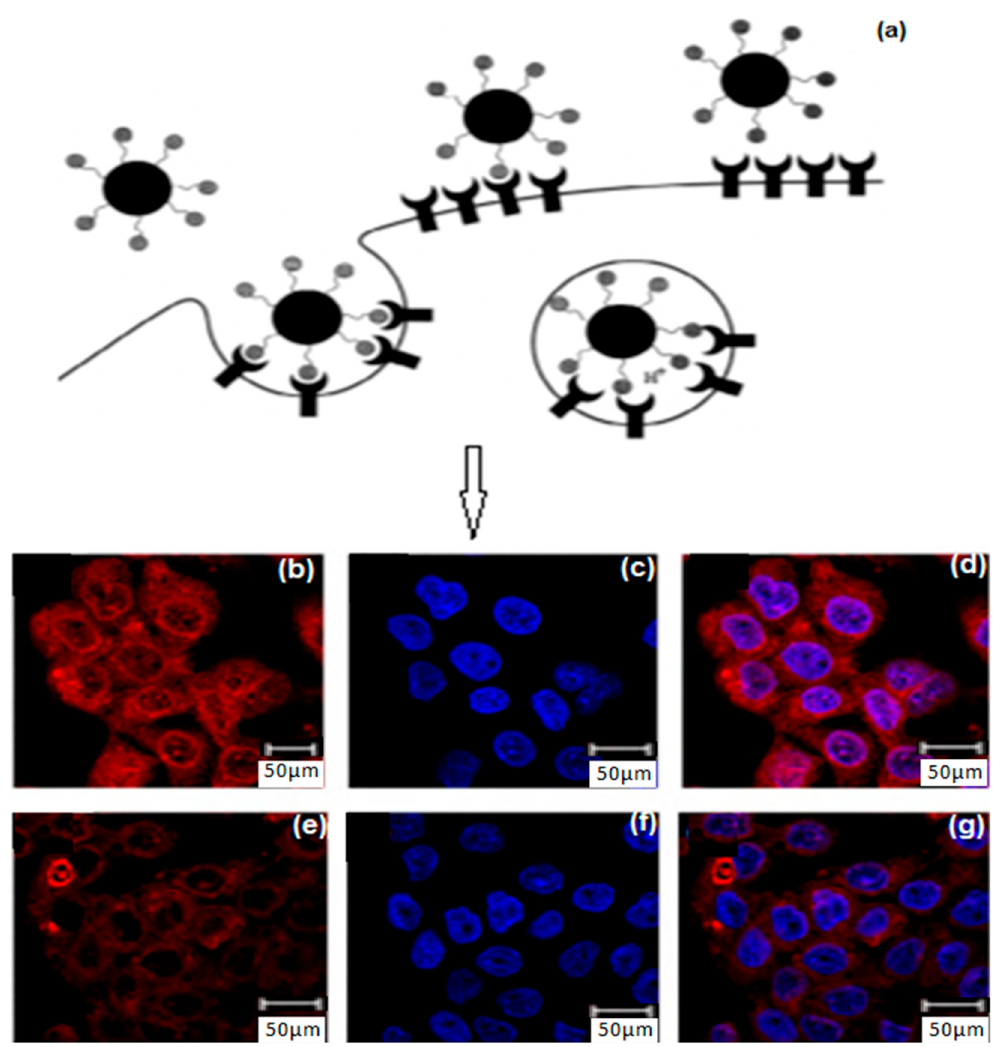
Figure 7. Schematic depiction of ( a ) active targeting, ( b – g ) confocal images of A431 cellular uptake incubated with cetuximab encapsulated micelles and lysotracker. The fluorescence intensity of A431 cells ( b – d ) treated with targeting micelles was 1.45 times higher than in cells incubated with antibody-free micelles ( e – g ) (Adapted with permission from Sudimack et al. [117]; Liao et al. [118].